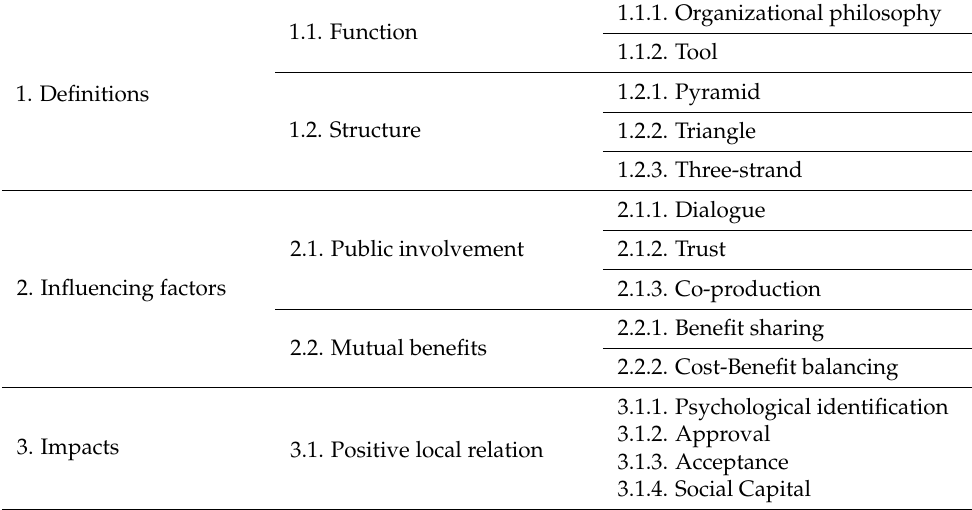
Table 1. Analytical framework of SLO.